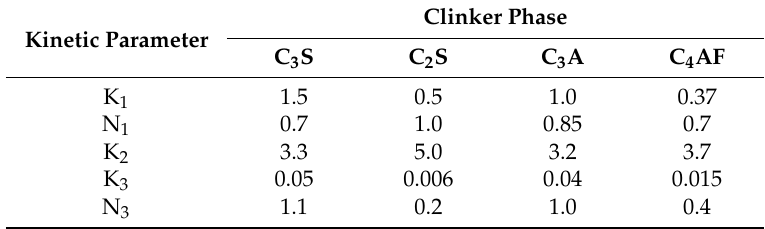
Table 1. The kinetic parameters of clinker phases at different hydration stages. Kinetic